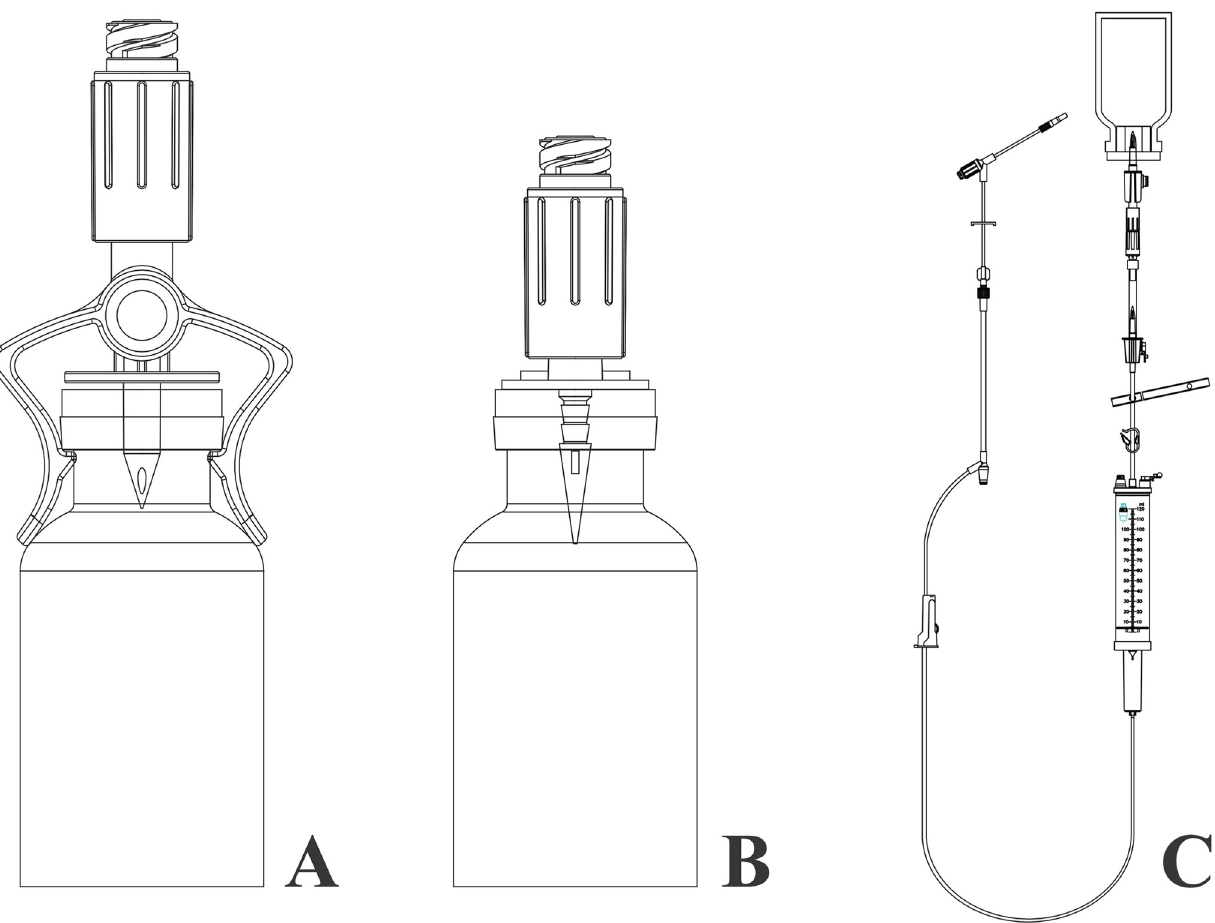
Fig 1. Illustrations of drug preparation and administration device assembly. (A) Vial access clip with DualGuard needleless connector attached to a drug vial. (B) Vial access device with DualGuard needleless connector attached to a drug vial. (C) Administration set with closed male luer and DualGuard needleless connector attached to an intravenous